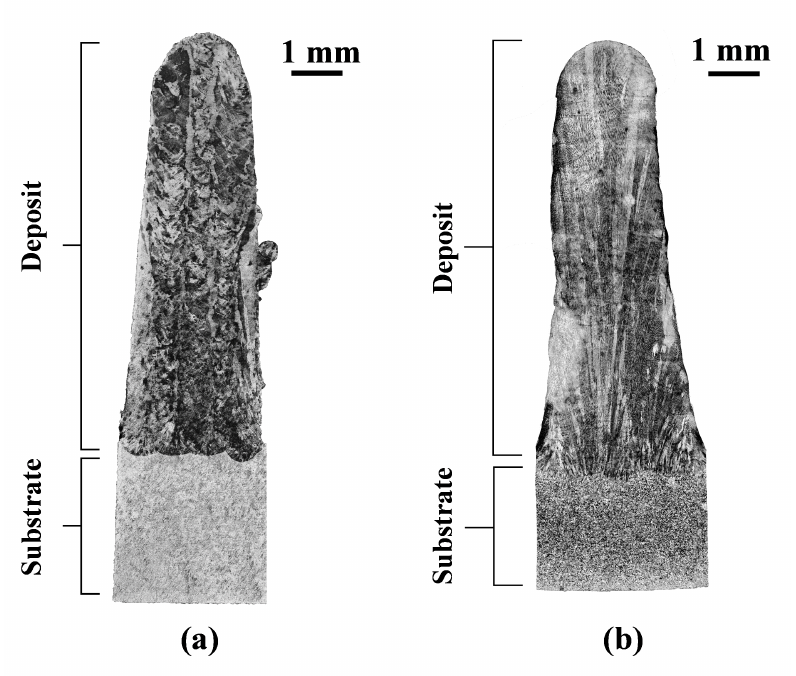
Figure 6. OM image of the etched cross-section of ( a ) the powder-fed L-DED specimen and ( b ) the wire-fed L-DED specimen.